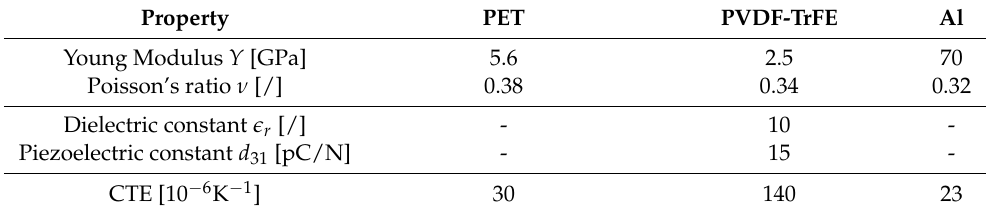
Figure 5. Comparison between experimental 30 ◦ cross sections of the influence functions of the six electrodes of the same row and a numerical simulation. The voltage applied is 100 V. Table 2. Material